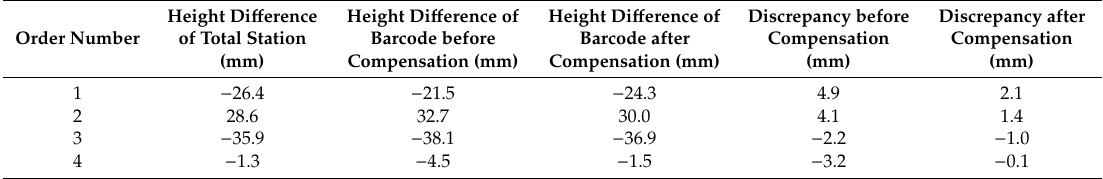
Table 7. Height di ff erences before and after tilting